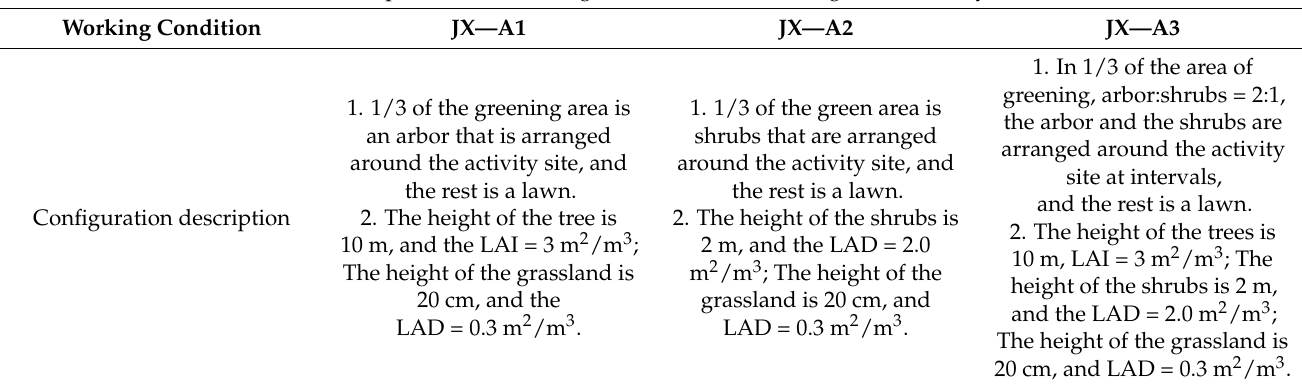
Table 3. Factors and working conditions of level setting.